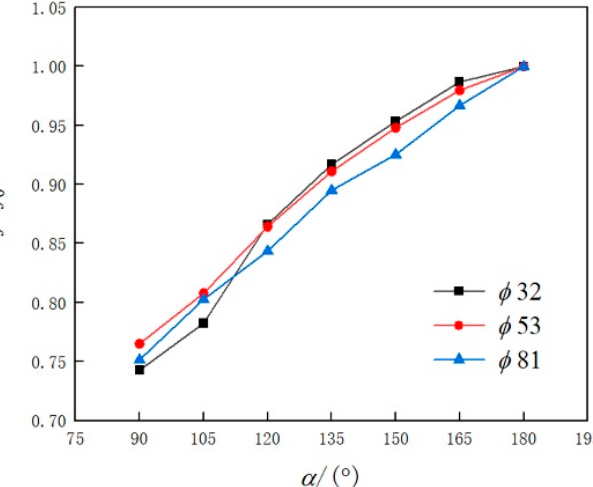
Figure 13. Relative frictional resistance coefficient f / f 0 changing with the central angle α for helical pipes.